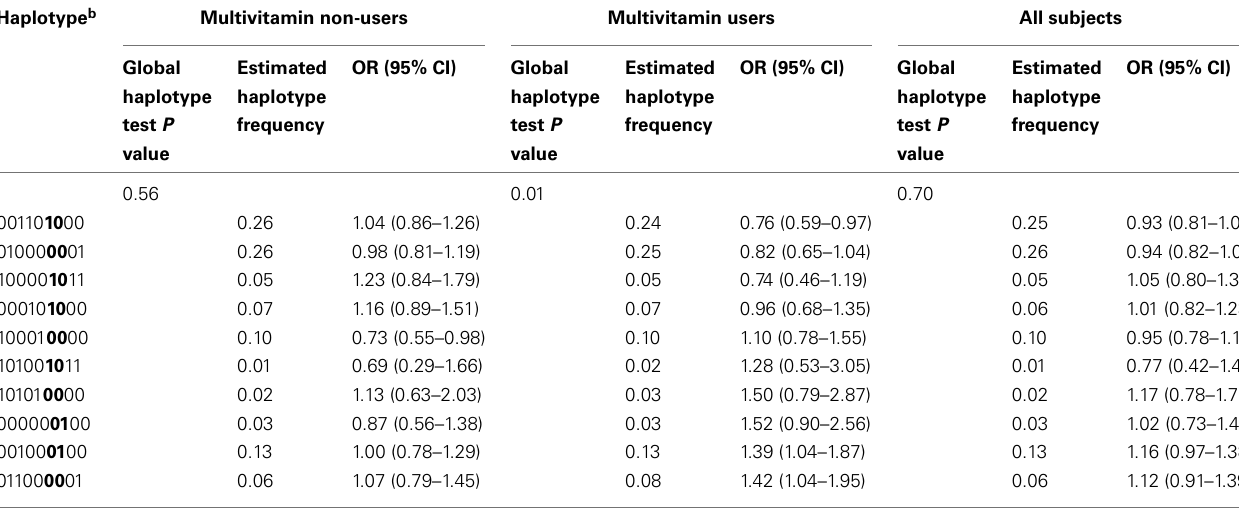
Table 4 |Association a between haplotypes derived from ATIC variants and ovarian carcinoma with and without stratification by multivitamin supplement use among 2,233 subjects (Phases 1 and 2), Mayo Clinic, and Duke University.